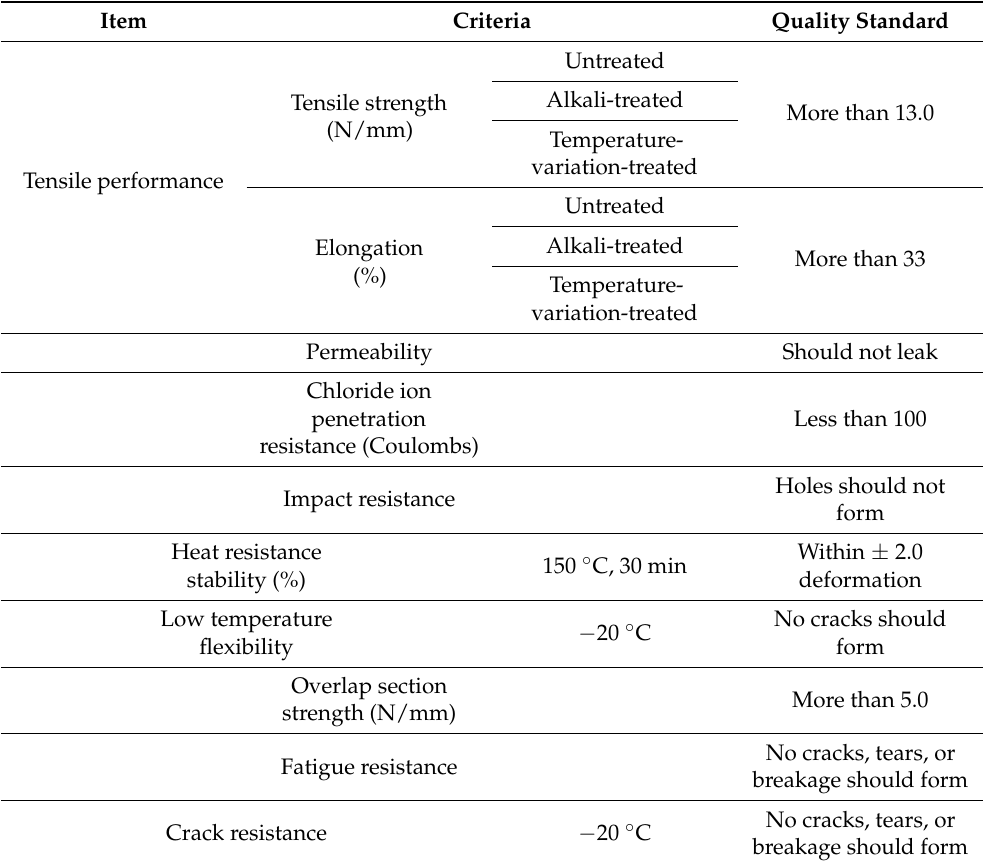
Table 2. Physical property evaluation criteria and performance standard of waterproofing sheet.